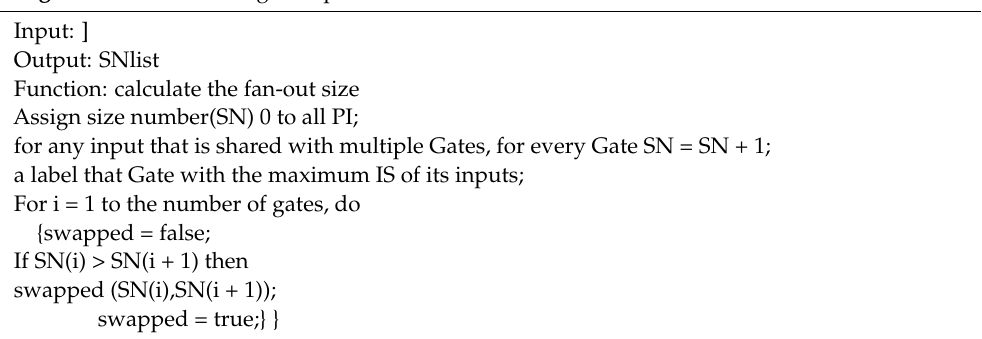
Algorithm 2: calculated gate input